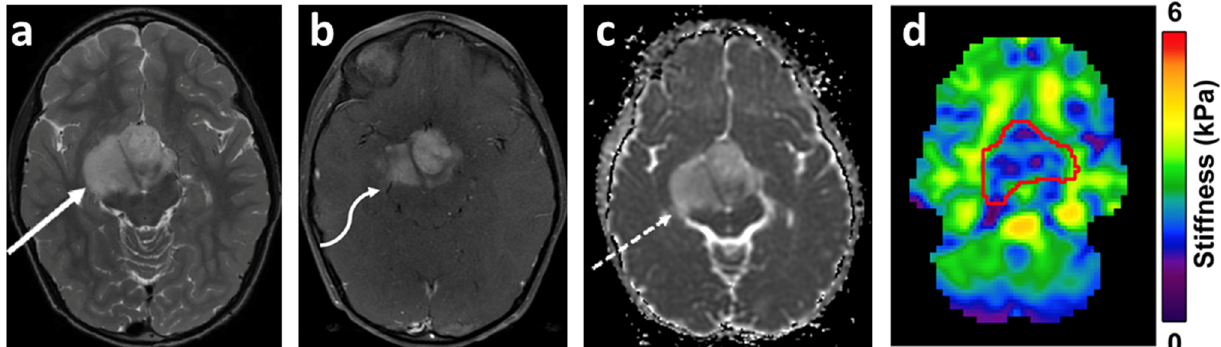
Figure 6. Eight-year-old boy with worsening headaches. Axial T2-weighted image ( a ) demonstrates a hyperintense, heterogeneous mass centered in the optic-chiasmatic, hypothalamic region (arrow). On the post-contrast T1-weighted image ( b ) there is moderate enhancement (arrow), with increased diffusivity on the ADC map ( c ) (arrow). On the stiffness map ( d ), the mass demonstrates heterogenous decreased stiffness (ROI) as compared to the uninvolved white matter. The tumor stiffness measured 2.48 ± 0.70 kPa, while the average brain stiffness excluding the tumor measured 2.83 ± 0.72. Pathology confirmed a ganglioglioma WHO grade I, with Ki-67: 3–4%. Genetic analysis depicted KIAA1549-BRAF fusion. Author’s institutional human ethics committee/institutional review board guidelines were followed for anonymized